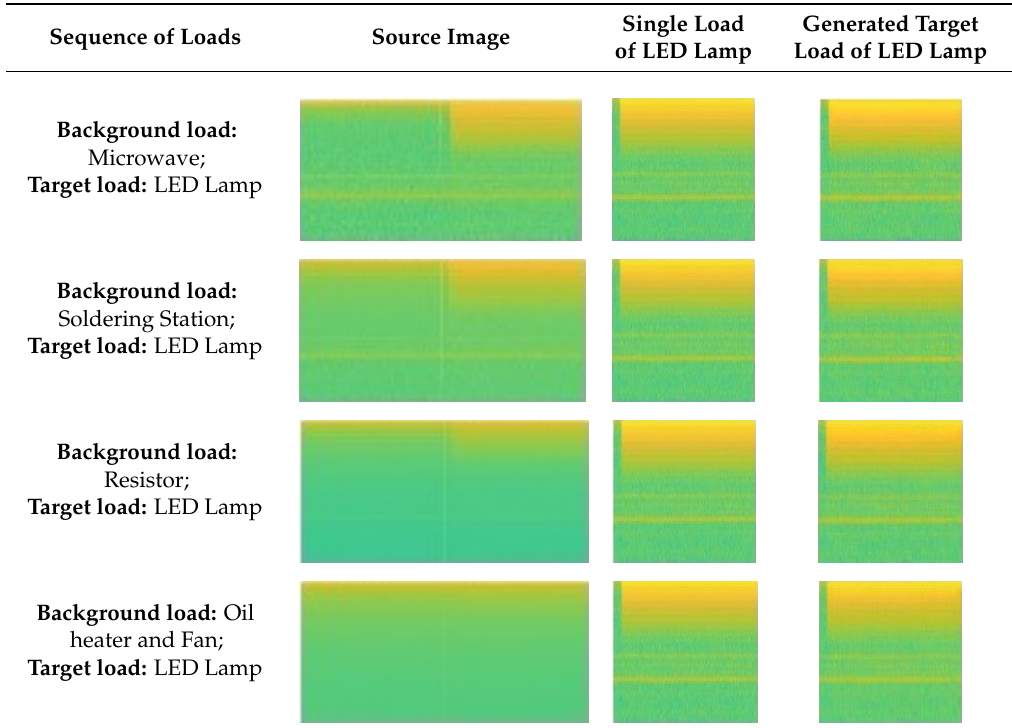
Figure 14. GAN Training Curve based on discriminate loss. Table 3. Several results of GAN inference with LED Lamp as target